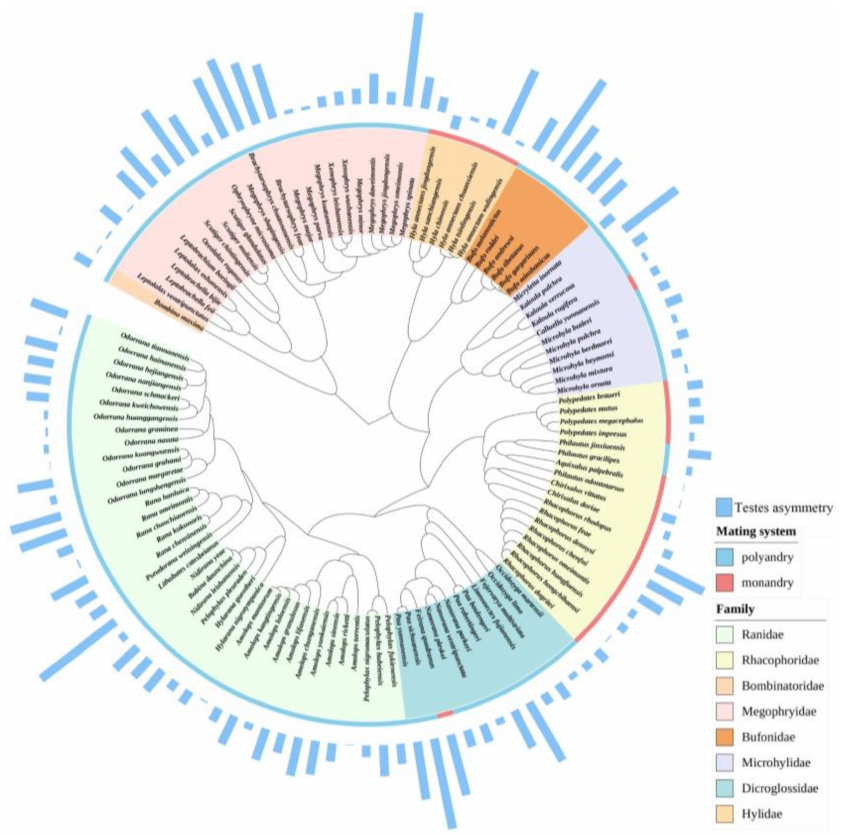
Figure 2. Phylogenetic tree of the 116 anuran species based on the three nuclear genes (RAG1, RHOD and TYR) and the six mitochondrial genes (CYTB, 12S, 16S, COI, ND2 and ND4) using BEAUTi and BEAST v.1.8.3. Blue histogram indicates the degree of testes size